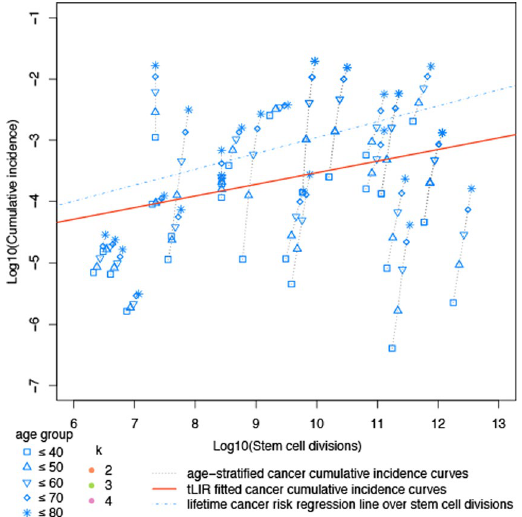
Figure 4. Relationship between cancer incidence and stem cell divisions among 30 cancer types. The lifetime cancer risk regression line is conceptually the same as that used by Wu et al . 11